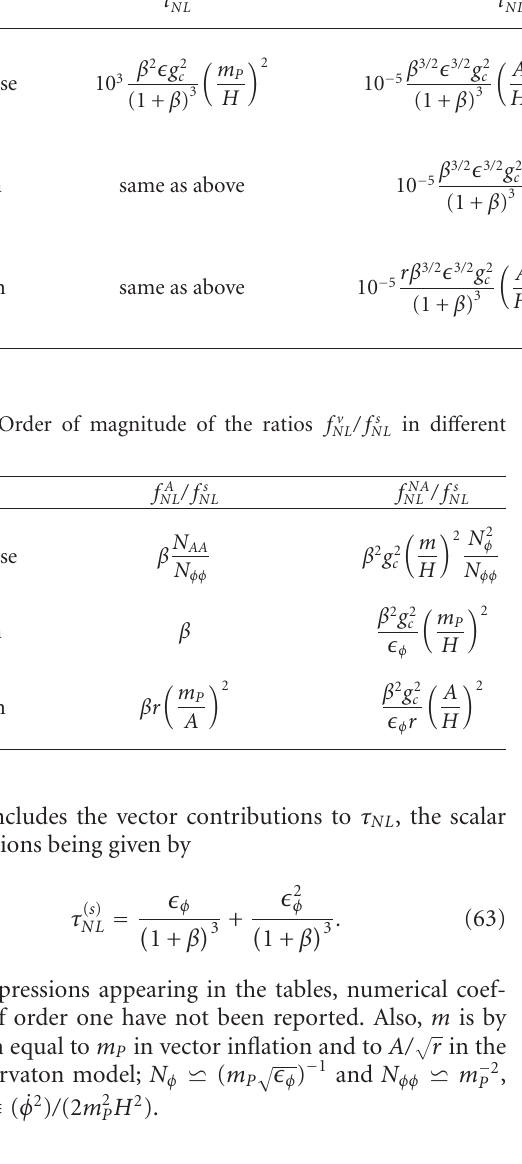
Table 2: Order of magnitude of the vector contributions to τ NL in di ff erent scenarios.